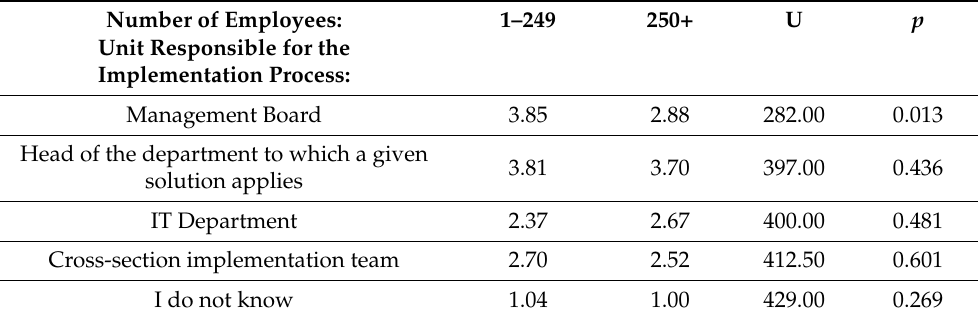
Table 13. Assessment of degree of unit responsibility for the implementation of Industry 4.0 solutions